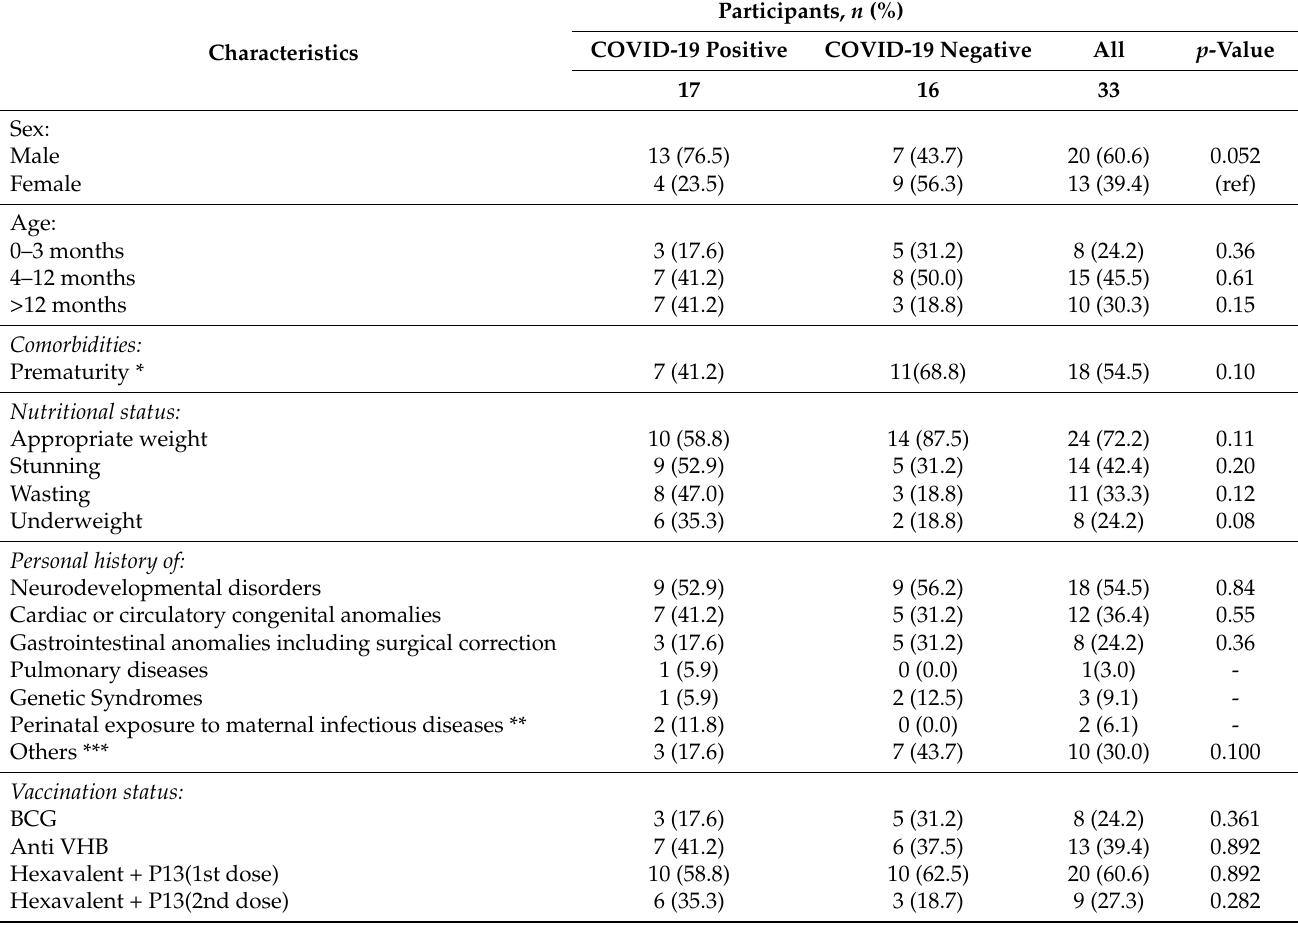
Table 1. The clinical and personal history features distribution for the studied groups.